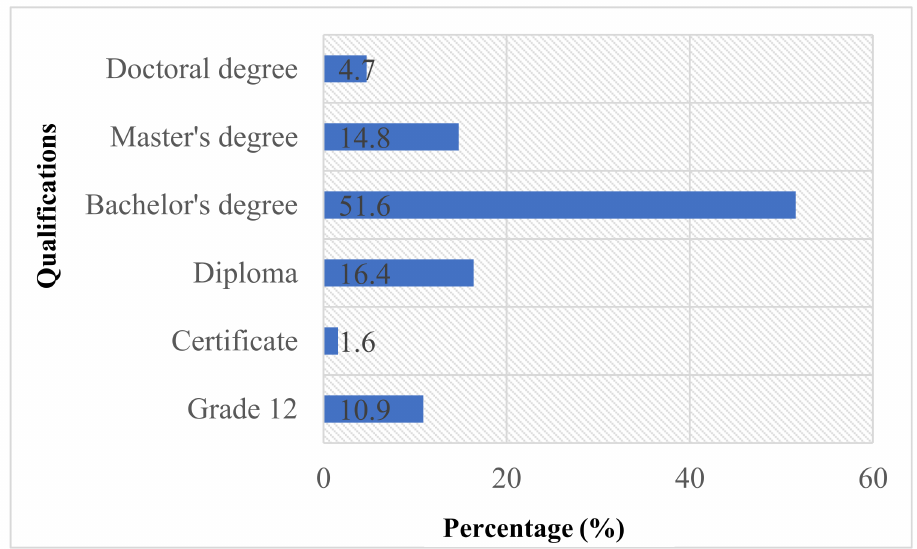
Figure 3. Level of education ranging from a grade 12 to a doctoral degree among the respondents from various